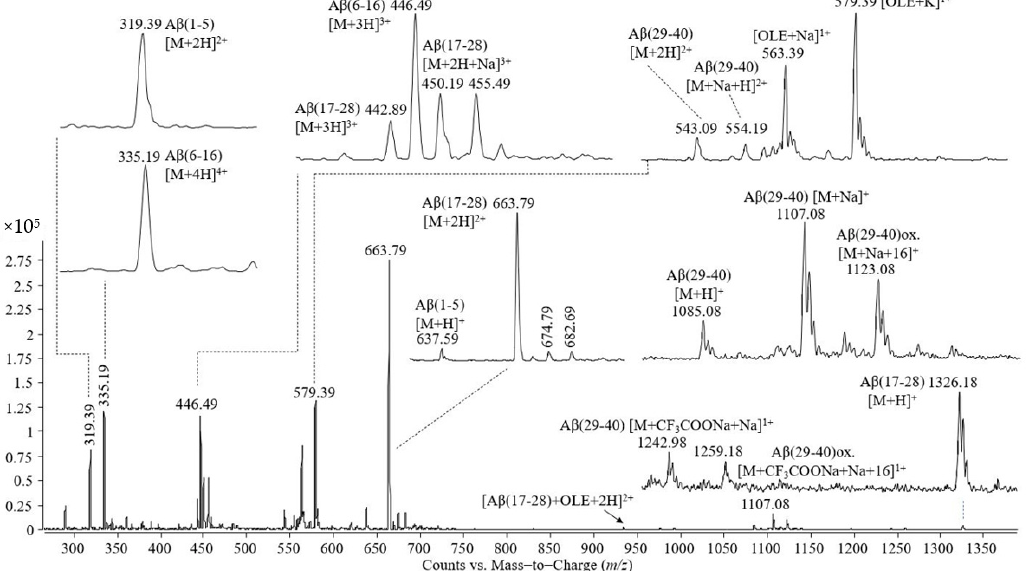
Figure 5. Mass spectrum obtained by ESI-triple quadrupole analysis of the proteolytic mixture resulting from A β (1–40) cleavage by trypsin, incubated with oleuropein for 30 min at 37 °C.